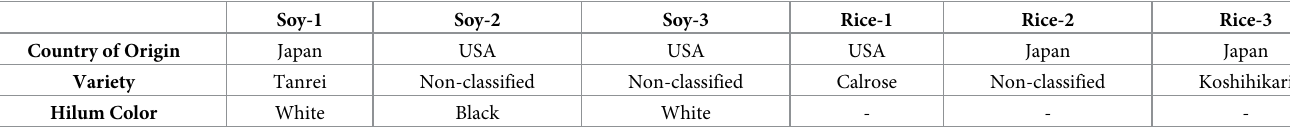
Table 2. Soybean and rice information.